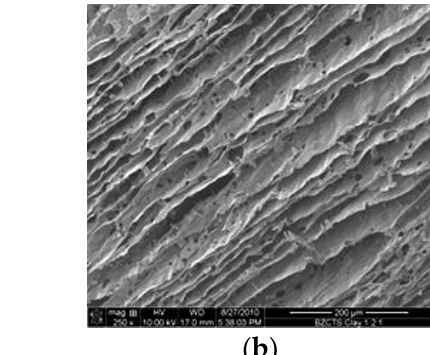
Figure 3. ( a ) Freeze-dried bisphenol A/tetraethylenepentamine (tepa) benzoxazine modified chi- tosan (1:1) (abbreviated as BA-tepa/CTS). ( b ) Freeze-dried BA-tepa/CTS reinforced with 5wt% of montmorillonite showing improved layer morphology. (Reproduced from the work in [37] with permission.)